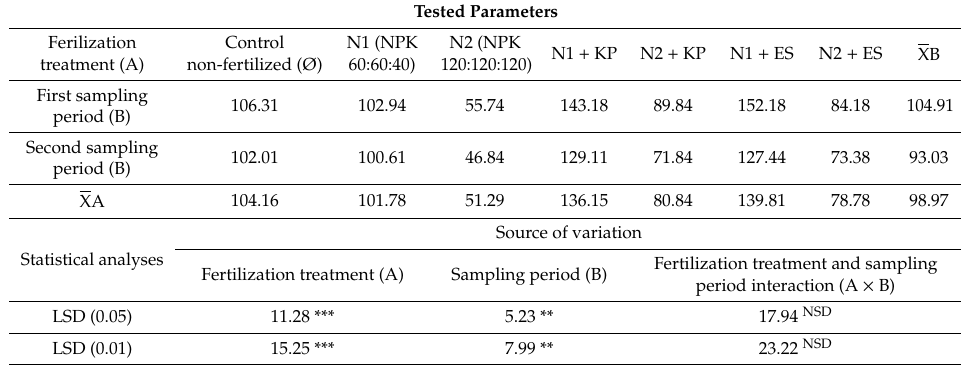
Table 3. Effect of the fertilization treatment (A), sampling period (B), and fertilization treatment and sampling